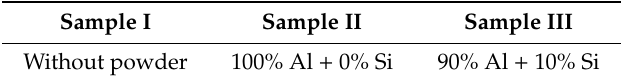
Table 2. Powder compositions (wt.%).